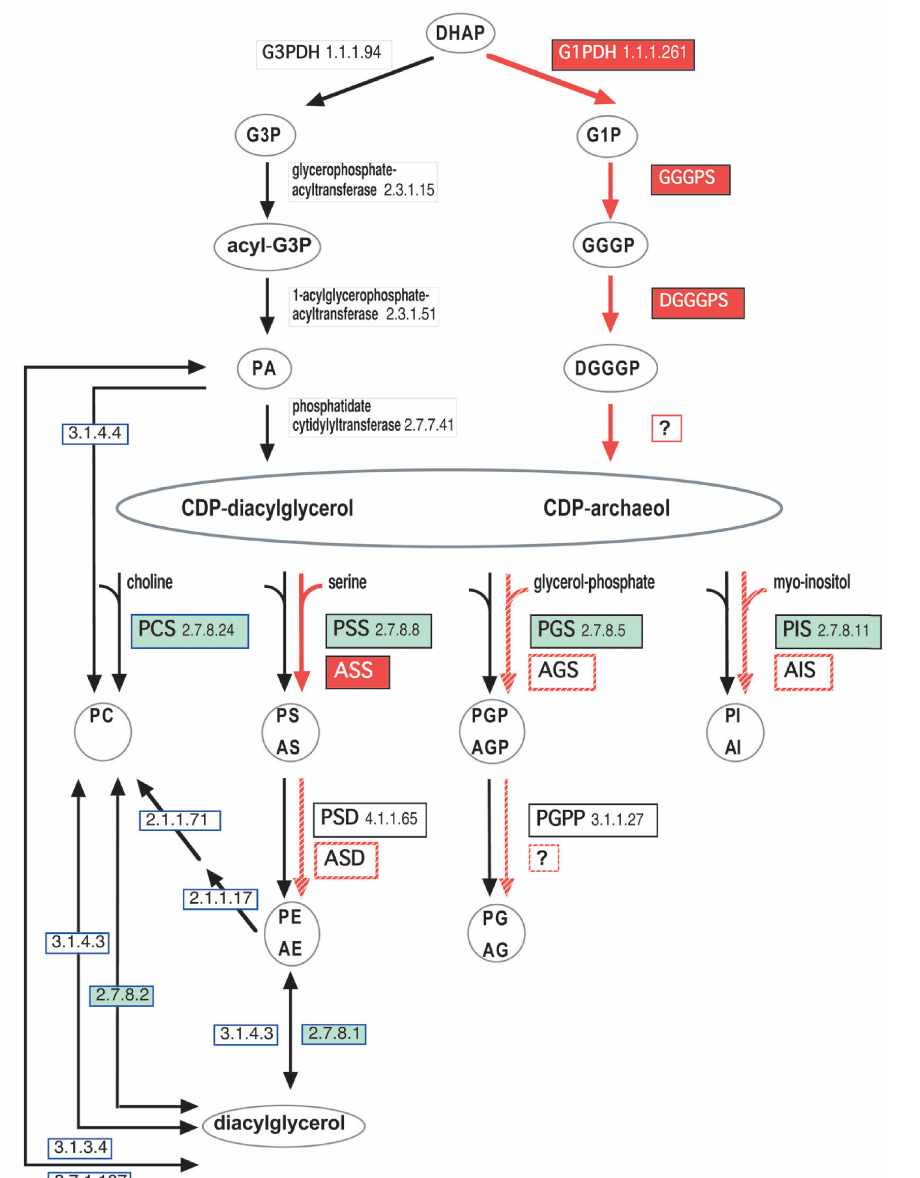
Figure 1. Synthetic pathways for polar lipids. The black ar- rows indicate the bacterial and eukaryotic pathway, and the red arrows denote the archaeal pathway. The red striped ar- rows show hypothetical steps in the archaeal pathway. The names or EC numbers in rect- angles indicate the enzymes responsible for the correspond- ing steps. Experimentally iden- tified archaeal enzymes are in- dicated by characters reverse-printed on red. Bacte- rial and eukaryotic enzymes belonging to the CDP alcohol phosphatidyltransferase family are shown in green rectangles. Enzymes in rectangles with blue frames are involved in